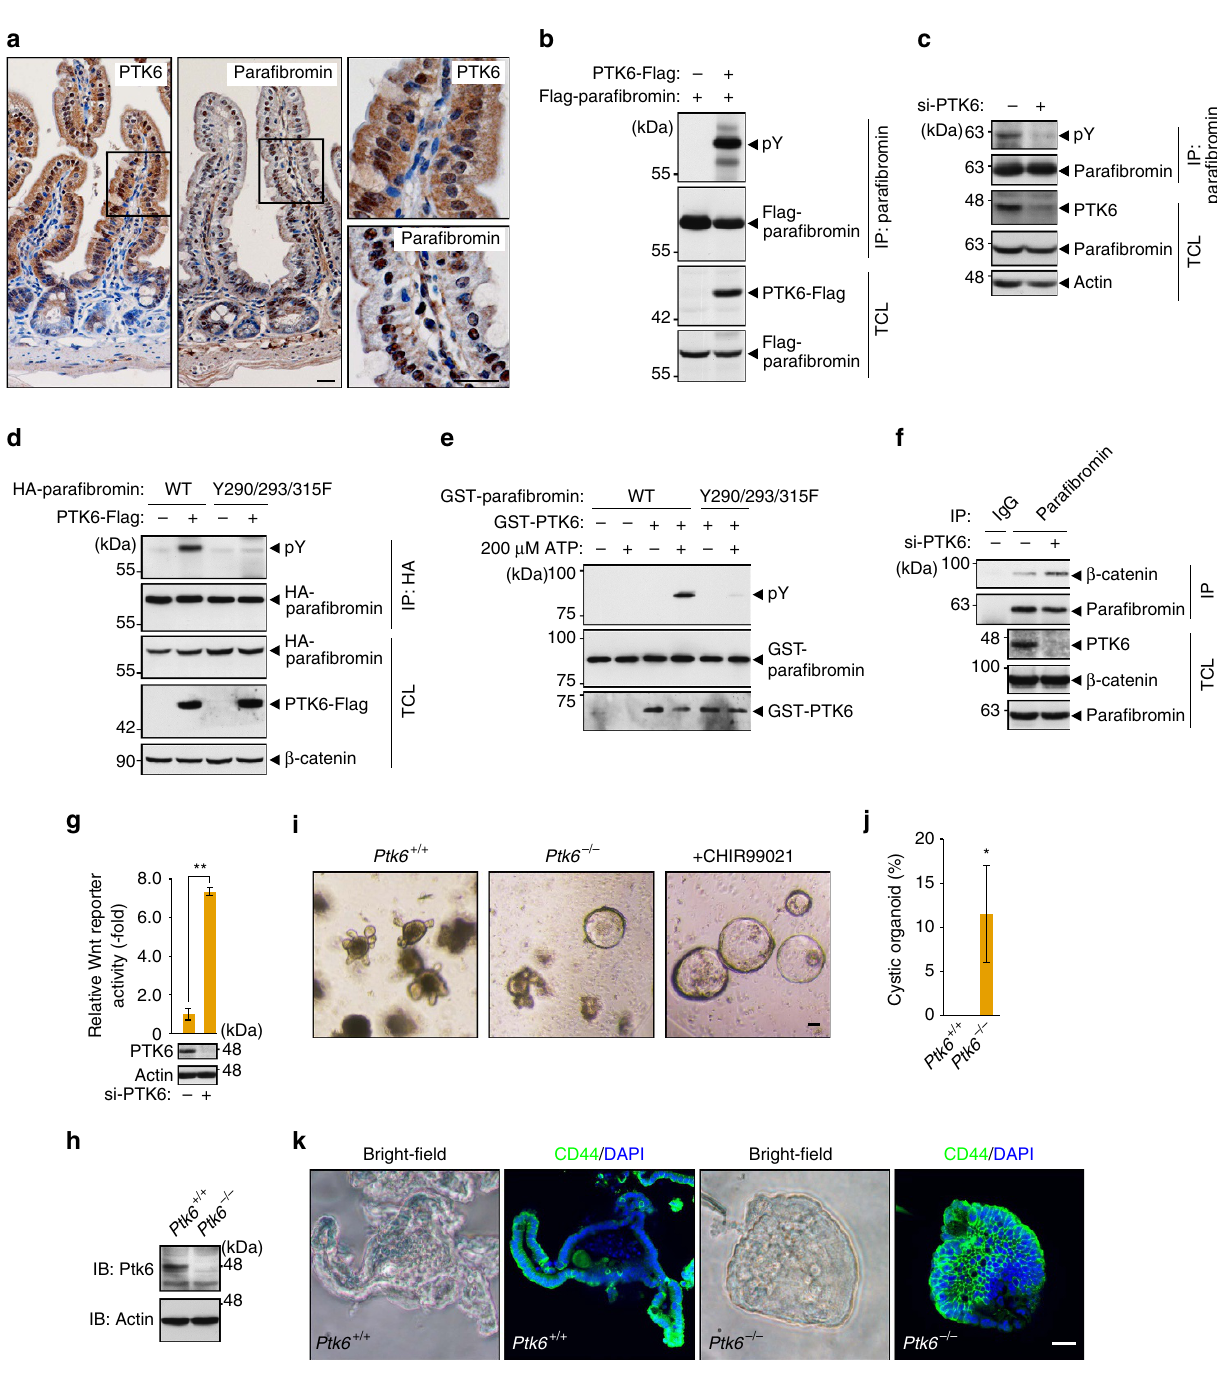
Figure 5 | PTK6 phosphorylates parafibromin and impairs its scaffold function. ( a ) Immunohistochemistry of the mouse small intestine confirming the co-expression of PTK6 and parafibromin. The right panels show higher-magnification images. Scale bars, 20 m m. ( b , c ) PTK6 regulates parafibromin tyrosine phosphorylation. AGS cells were transfected with the indicated vectors ( b ) or si-PTK6 ( c ). Total cell lysates (TCLs) were sequentially immunoprecipitated (IP) with the indicated antibodies. ( d ) Y290/293/315F mutations abolish parafibromin phosphorylation by PTK6. AGS cells were transfected with the indicated vectors. TCLs were sequentially immunoprecipitated (IP) with the indicated antibodies and immunoblotted. ( e ) In vitro kinase assays indicating parafibromin is a direct substrate of PTK6. Purified recombinant parafibromin and PTK6 were incubated with 200 m M ATP. The reaction mixtures were subjected to immunoblotting. ( f ) PTK6 regulates parafibromin/ b -catenin interaction. AGS cells were transfected with si-PTK6. TCLs were sequentially immunoprecipitated (IP) with the indicated antibodies. ( g ) PTK6 knockdown in AGS cells resulted in increased Wnt-reporter activity in the luciferase reporter assay ( n ¼ 3, mean ± s.d. ** P o 0.01; a two-tailed unpaired Student’s t -test). ( h – k ) Ptk6 (cid:2) / (cid:2) intestinal organoids show less-differentiated ‘cystic’ growth and expanded Wnt signal activation. Immunoblot analysis ( h ), morphology ( i ), a percentage of cystic organoids ( j ) and CD44 immunostaining ( k ) of control and Ptk6 (cid:2) / (cid:2) intestinal organoids ( n ¼ 3, mean ± s.d. * P o 0.05; Wilcoxon rank sum test). Scale bar, 50 m